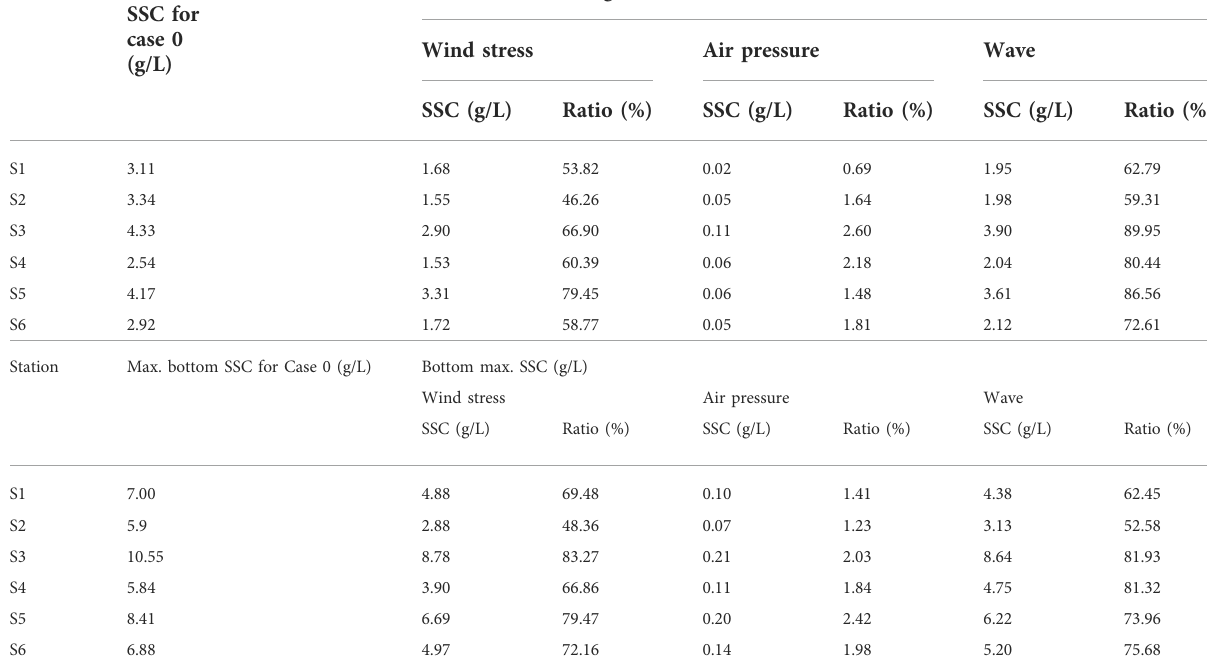
TABLE 4 Characteristic SSC caused by wind